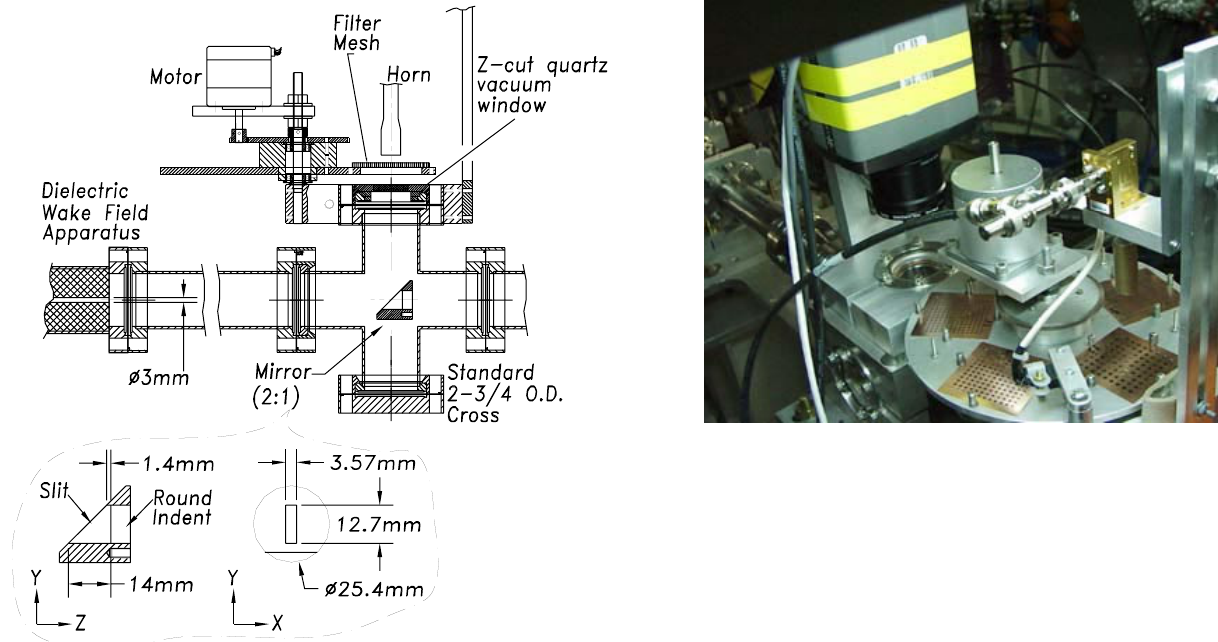
FIG. 4. (Color) Drawing of a portion of the beam line (left), showing transverse radiation output using a 45 (cid:3) deflecting mirror, and a picture of the apparatus, showing the detector, horn antenna, and rotational table equipped with 2D-mesh filters (transverse radiation output is below the